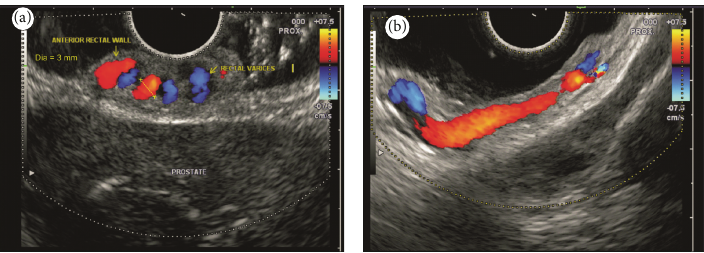
Figure 5: (a) Submucosal varices noted in a person who has undergone surgery for hemorrhoids. Presence of fresh blood was noted but endoscopy showed no rectal varices. (b) A long submucosal course of rectal varices is seen coming from the lateral wall of the rectum towards the anterior